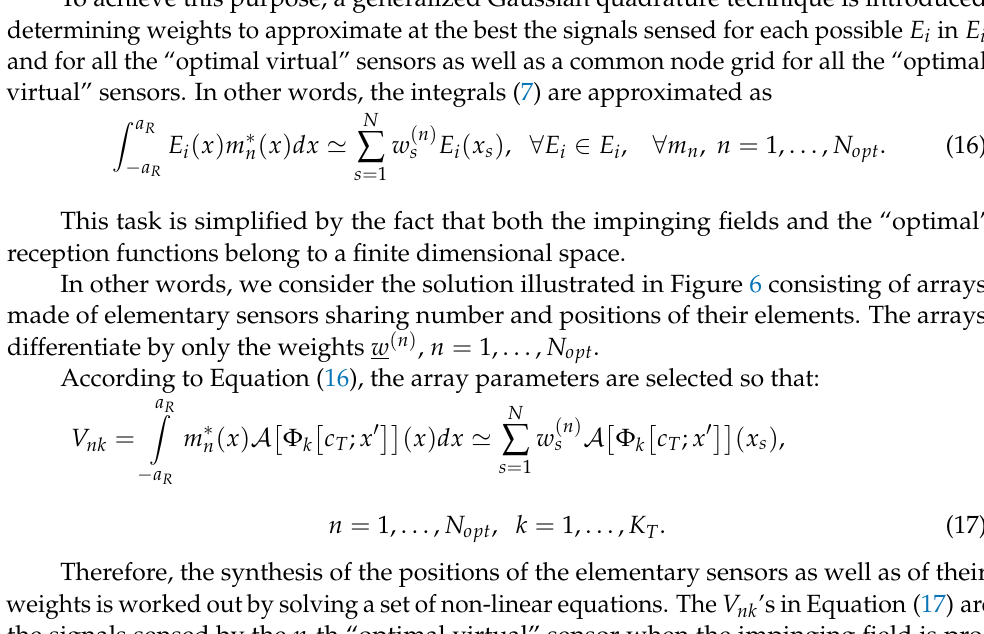
Figure 5. Subsequent use of the discretized “optimal virtual” sensors to measure the transmitted